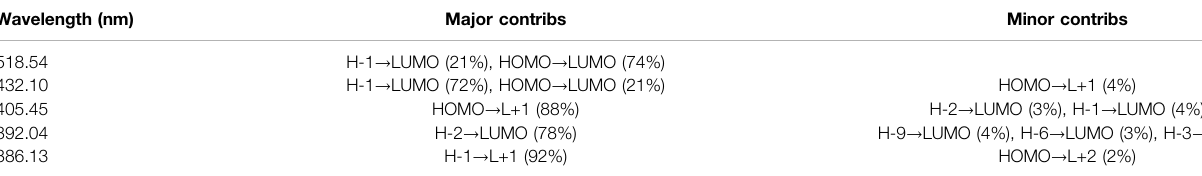
TABLE 4 | The details of absorption spectra for the sila-dodecahedrane and O and N-Link glycoproteins. Wavelength